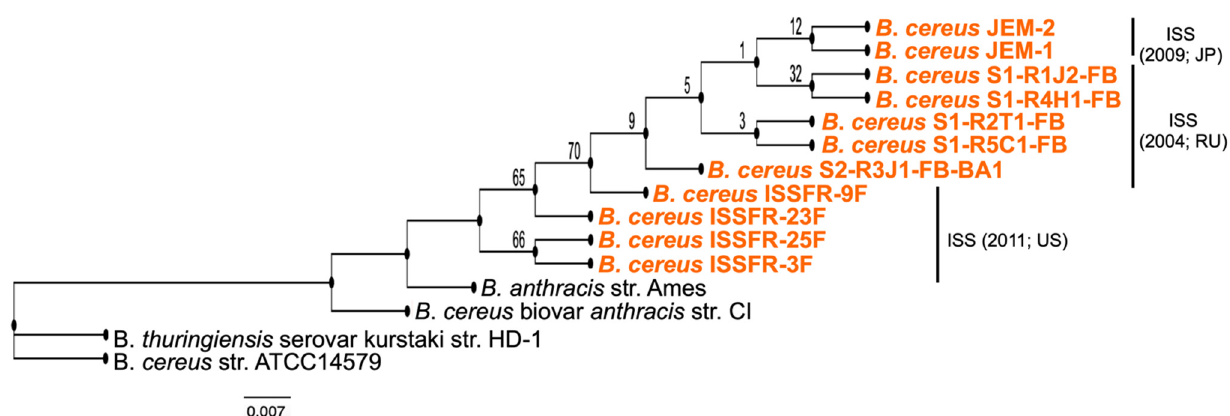
Figure 3. ISS Bacillus strains are closely related to the pathogenic Ames B. anthracis strain ISS strains and very closely related to each other. Maximum-likelihood phylogenetic tree was constructed using the PathoSystems Resource Integration Center (PATRIC) using complete genome sequences of 11 ISS Bacillus isolates sampled in the ISS between 2005 and 2011 (indicated by orange font) and four terrestrial Bacillus isolates for comparison. B. anthracis str. Ames and B . cereus biovar anthracis str. CI are pathogenic